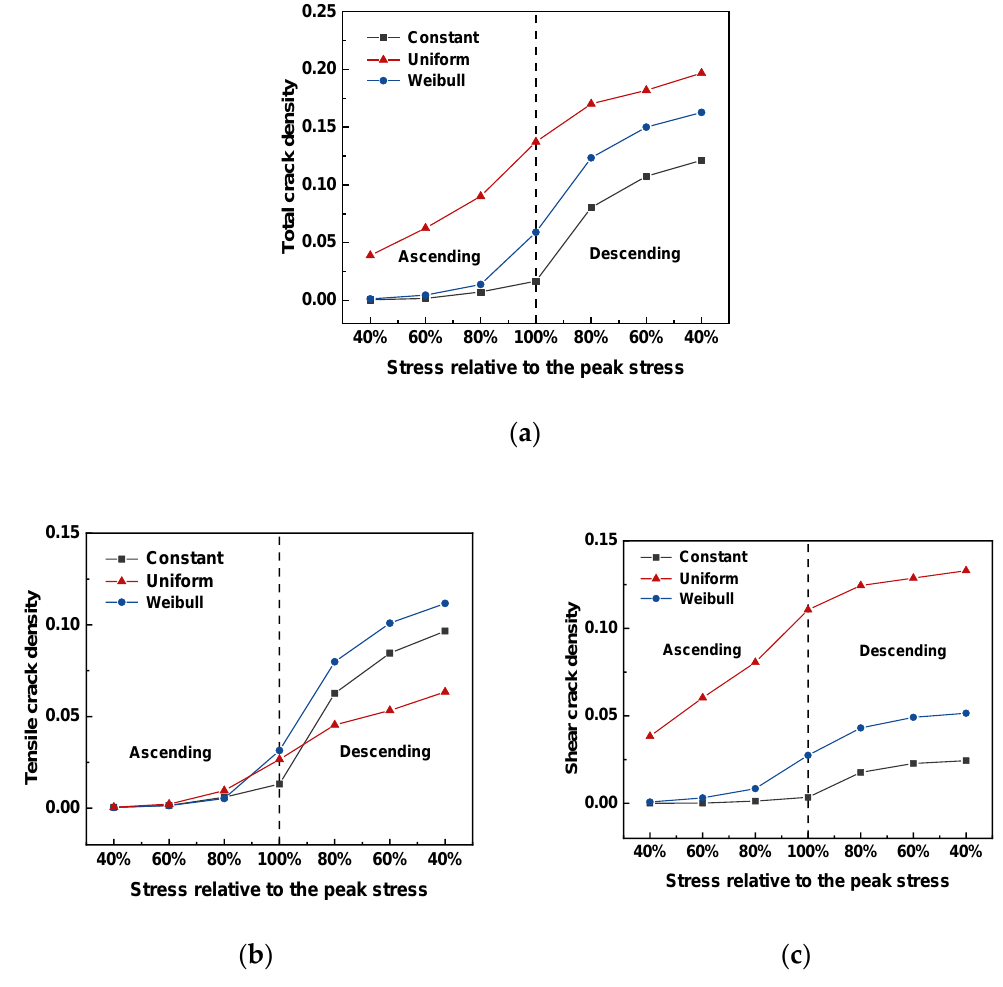
Figure 11. ( a ) Total crack density, ( b ) tensile crack density, and ( c ) shear crack density with respect to stress relative to the peak.